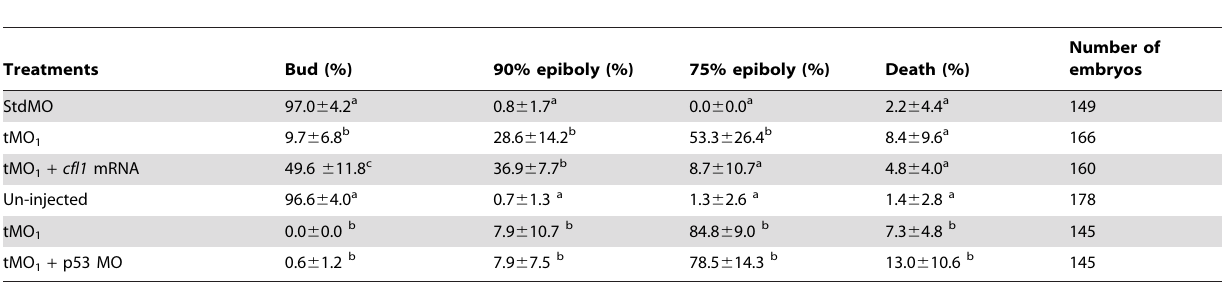
Note : Embryos at 1-cell stage were injected with cfl1 tMO 1 (7.5 ng per embryo) without or with cfl1 mRNA (100 pg per embryo) or p53 MO (7.5 ng per embryo) and examined at 10 hpf. The percentages of epiboly progression were recorded. These experiments were repeated 4 times. Data are presented as means 6 standard deviation. Experimental values are compared within groups, subjected to ANOVA and the mean separation was done by Duncan’s Multiple Range Test (DMRT). Values with different lettering in their superscripts in the same column of each group are significantly (p , 0.05) from each